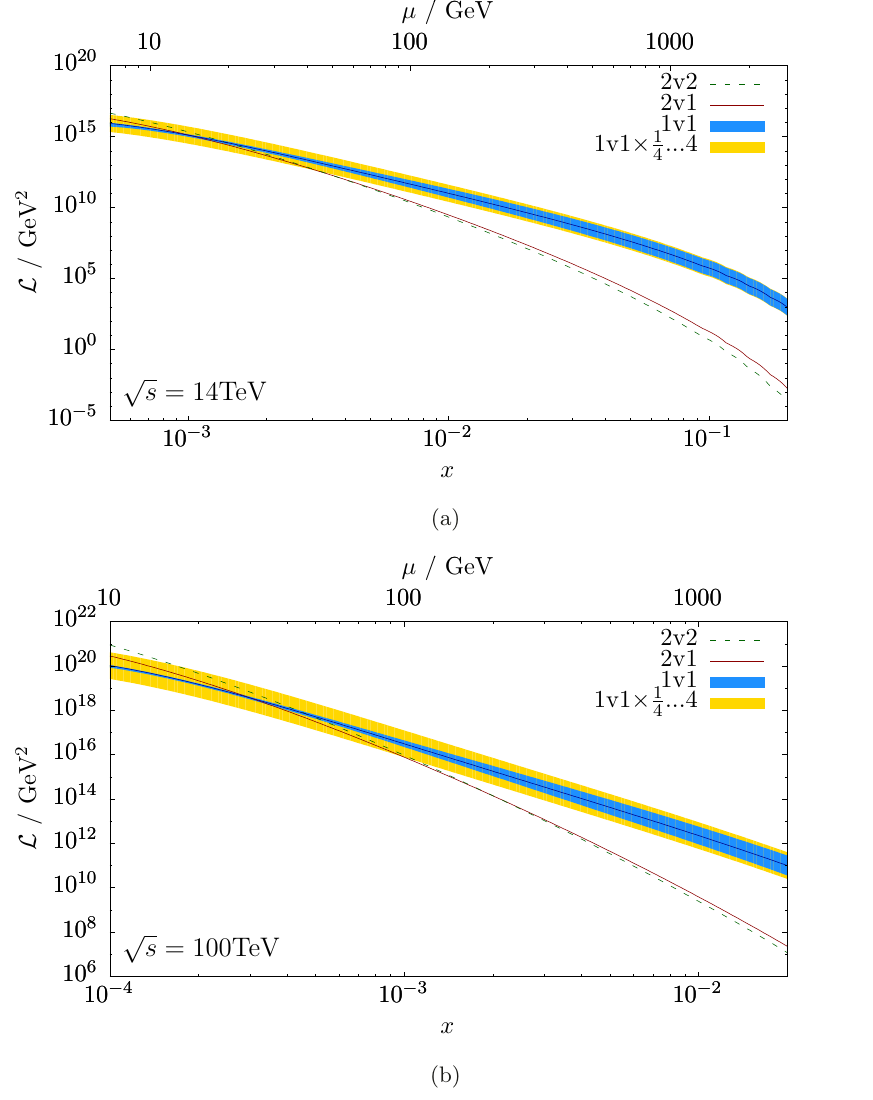
Figure 15 . DPS luminosities in the gg channel with all x values in the DPDs set equal. The collider energy √ s is fixed to 14 TeV (a) or to 100 TeV (b). The scales of the DPDs, set to µ = x √ s , are given at the top of the